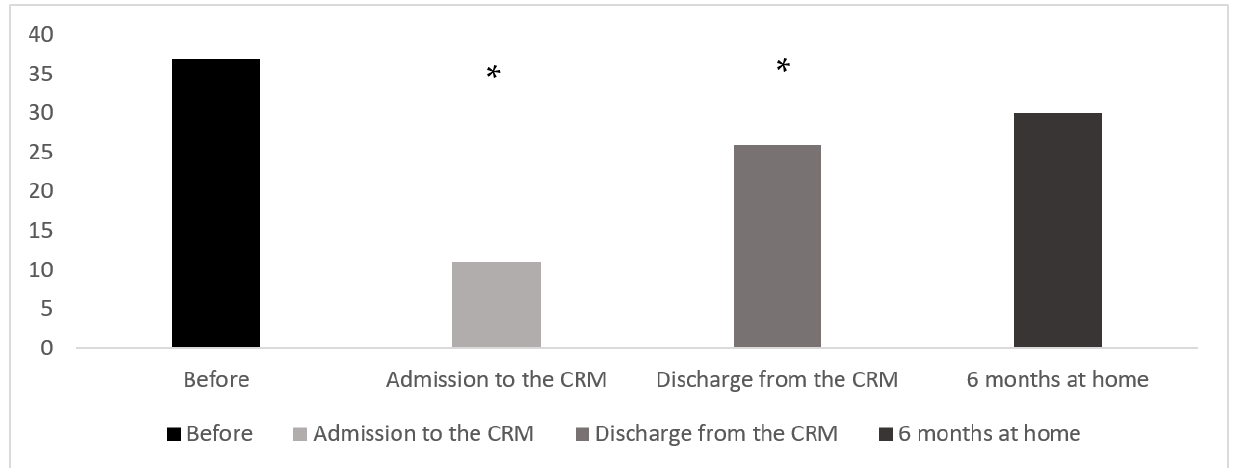
Figure 2. Autonomy recovery throughout the health care pathway, from before COVID-19 infection to 6 months after returning home (number of patients classified in GIR 5 and 6). * Sig diff between mobility score at admission to the rehabilitation center and at discharge.